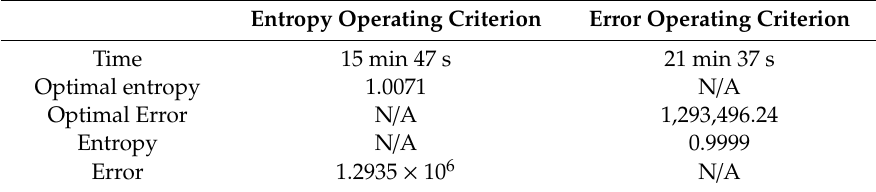
Figure 11. The ACKF processed data, the corrected data, and the di ff erentiation of these types of data. ( a ) Broadband (BR) thermopile; ( b ) λ 2 thermopiles and ( c ) di ff erentiation of the preprocessed and corrected data of λ 1 thermopile. Table 3. The operating coe ffi cients of the entropy and error operating criteria.